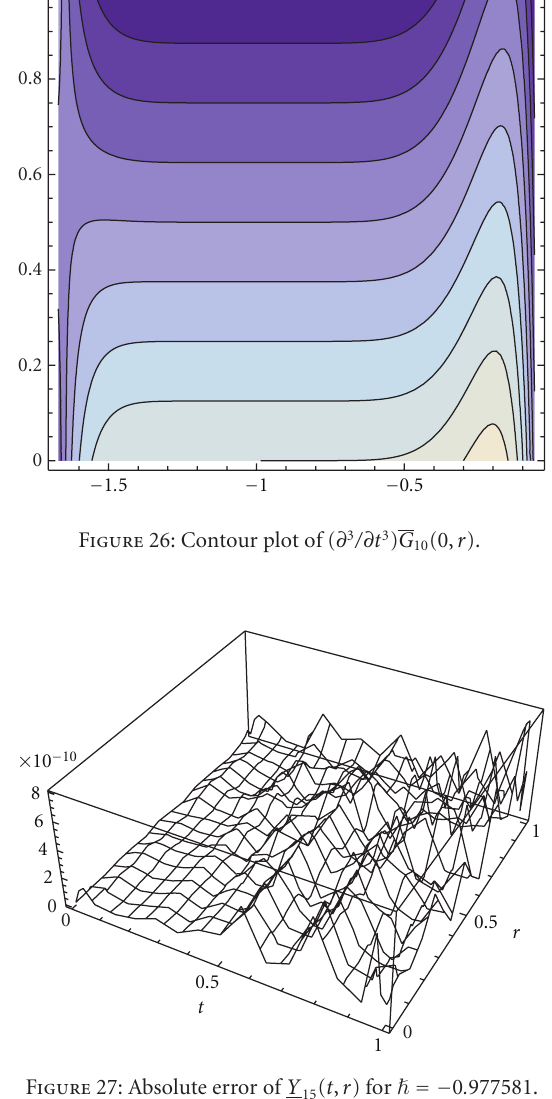
( t , r ) for (cid:2) = − 0 . 977581. 15